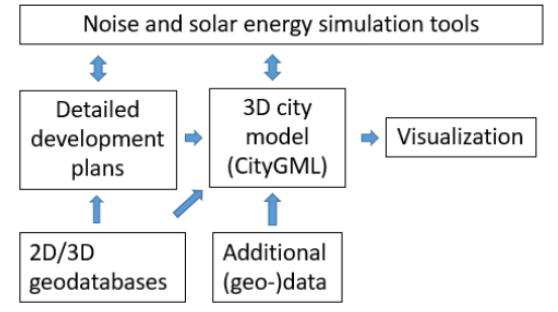
Figure 1. Data flow to support